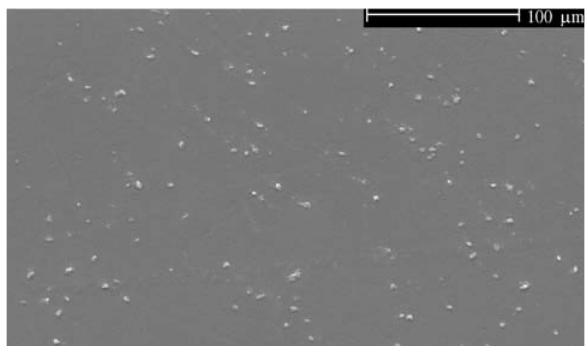
Figure 4. Micrographs of samples with (a) 5% BaO, and (b) 10% BaO.